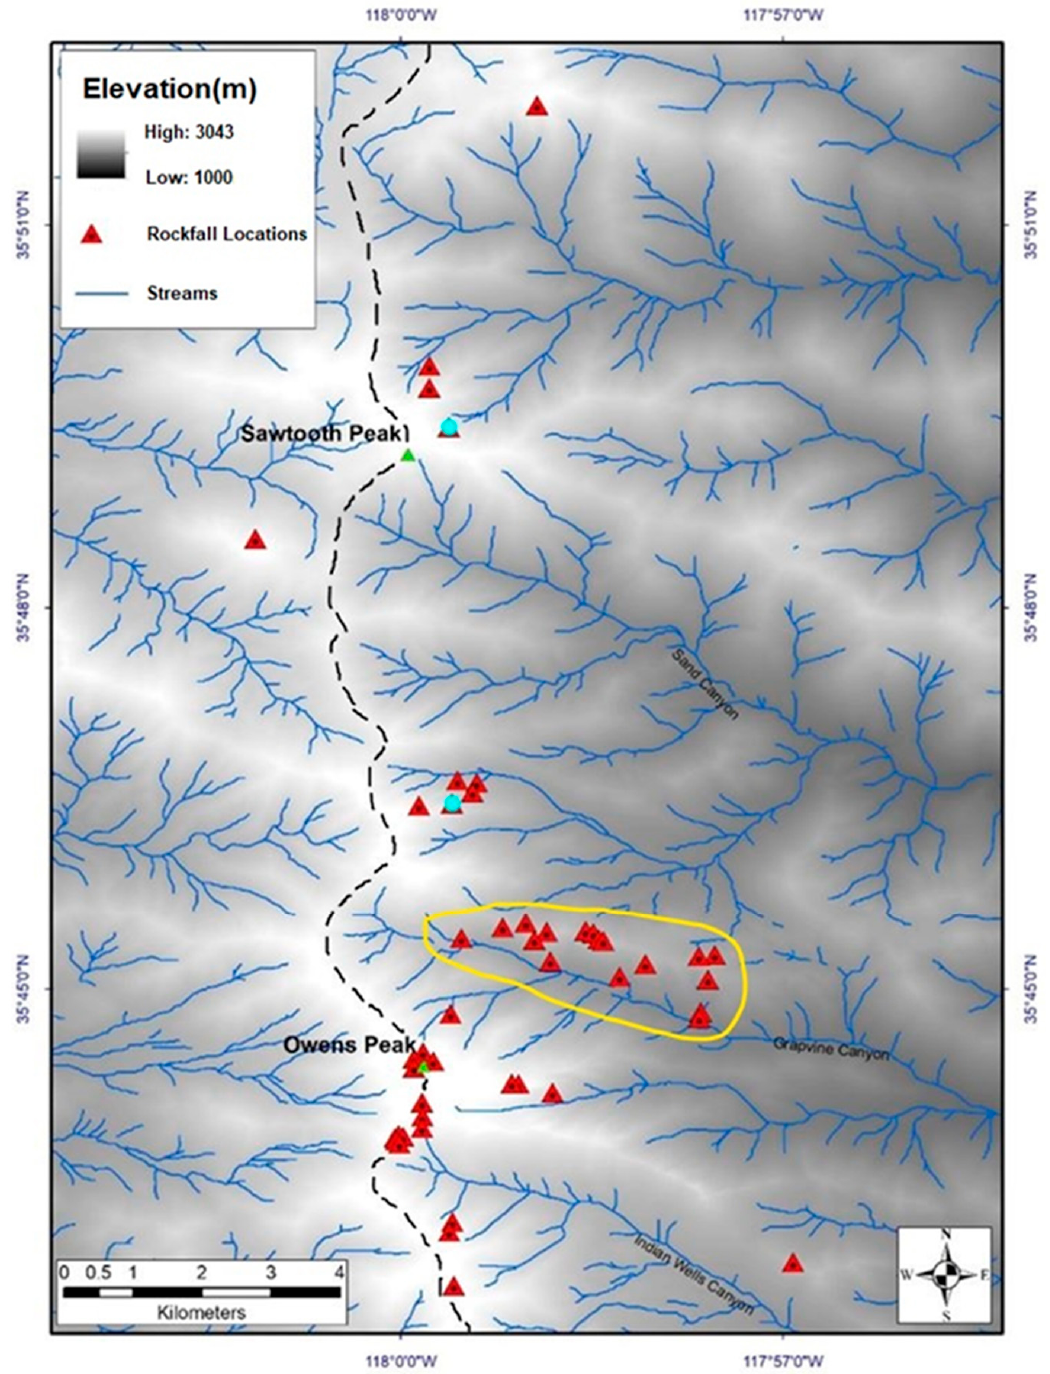
Figure 8. Rockfall locations Ridgecrest M W 7.1 event. The main Sierra Nevada crest (black dashed line) runs through the region between Owens and Sawtooth Peaks at an average elevation of ~2300 m. Failures with blue dots superimposed are the largest observed (>15,000 m 2 ). The Sawtooth Peak failure (upper light blue dot) is shown in detail in Figure 10. An example from the Grapevine Canyon failure zone (yellow circled region) is shown in detail in Figure